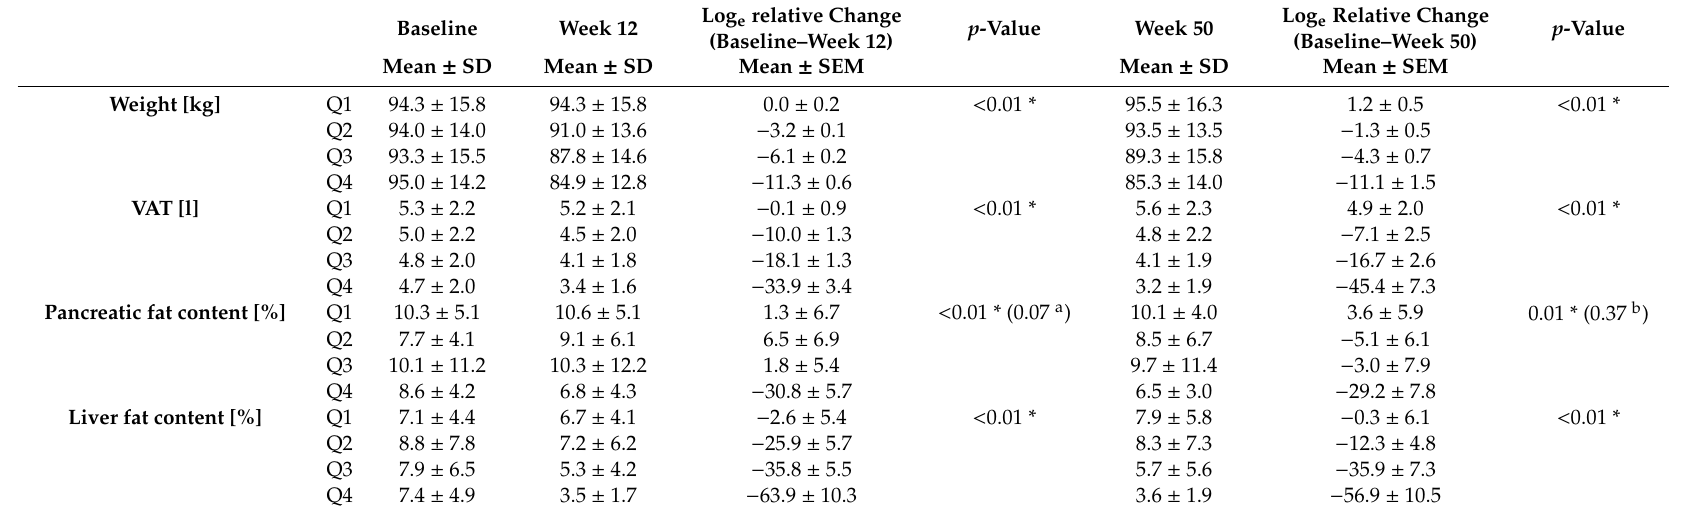
Table 3. Mean values and relative change (%) in weight, visceral adipose tissue, pancreatic fat content, and liver fat content in week 12 and week 50 across the weight-loss